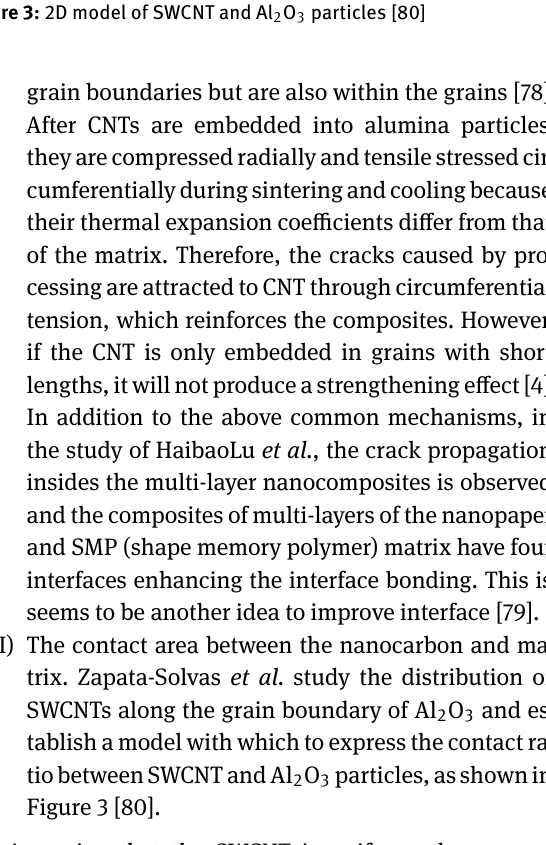
Figure 3: 2D model of SWCNT and Al 2 O 3 particles [80]